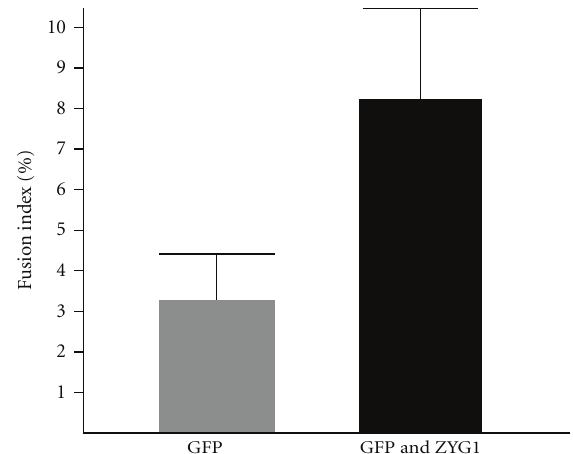
Figure 8: Enhanced formation of multinucleate cells by trans- fecting with the mzyg1 gene. The percentages of cells containing more than two nuclei are shown as fusion indexes. The pIRES2- AcGFP vector or pIRES2-AcGFP vector containing mzyg1 gene was transfected into C2C12 cells as described in Section 2. After 1 day, cells were fixed with 4% paraformaldehyde and mounted in PBS containing 20% glycerol and DAPI (final concentration: 2.5 μ g/mL) after three washings with PBS. The numbers of cells and nuclei stained with DAPI were counted. Three samples in two independent experiments were counted (about 500 ∼ 1,000 cells/sample). The fusion index (ratio of the cell number participated in cell fusion to the total cell number) was calculated by the following formula: Fusion index (%) = 2 × (The number of cells containing 2 nuclei) + 3 × (The number of cells containing 3 nuclei) ··· n × (the number of cells containing n nuclei)/1 × (The number of cells containing 1 nucleus) + 2 × (The number of cells containing 2 nuclei) + 3 × (the number of cells containing 3 nuclei ··· n × (The number of cells containing n nuclei) × 100. GFP; C2C12 cells transfected with the pIRES2-AcGFP vector. GFP and ZYG1; C2C12 cells transfected with the pIRES2-AcGFP vector containing the mzyg1 gene. Bars: standard